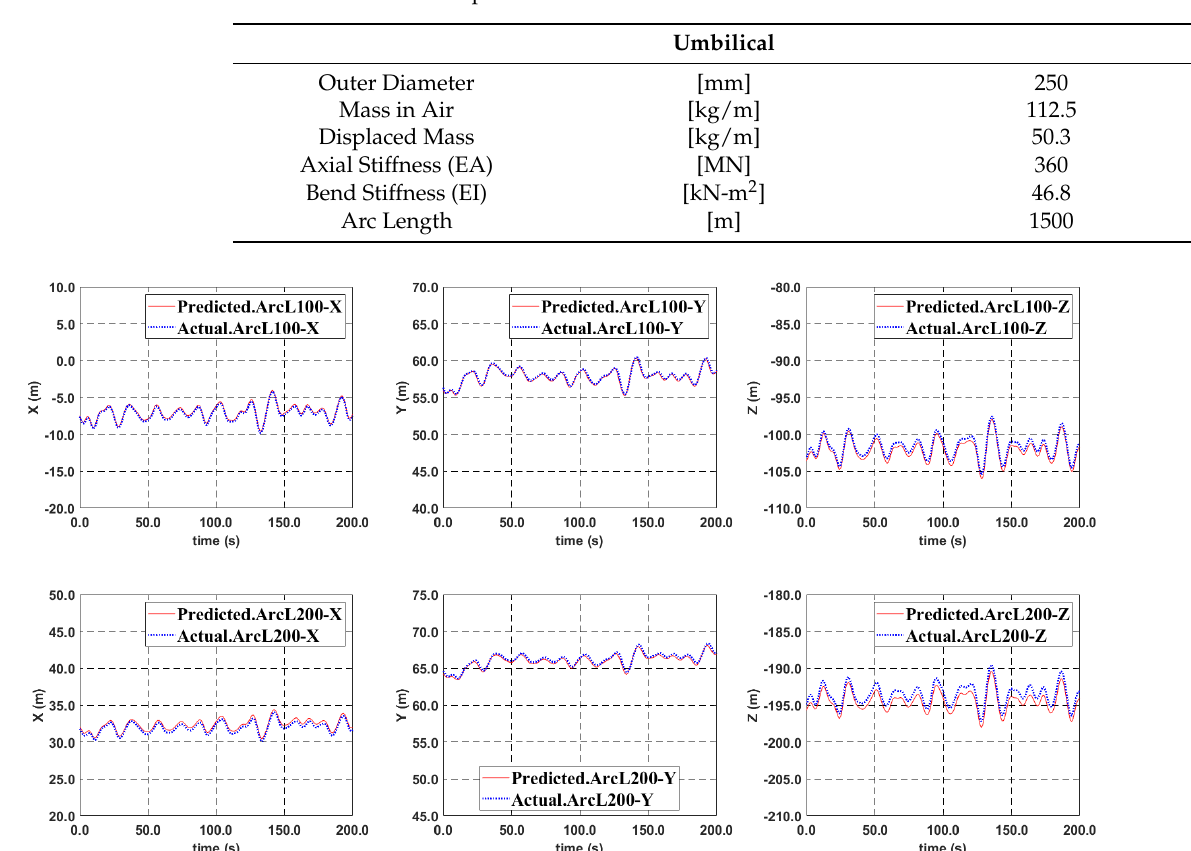
Figure A3. Displacement Tracing up to Target point (200 m Arc Length), 100-yr Storm, WD1000, Sensor Interval = 100 m, Umbilical.